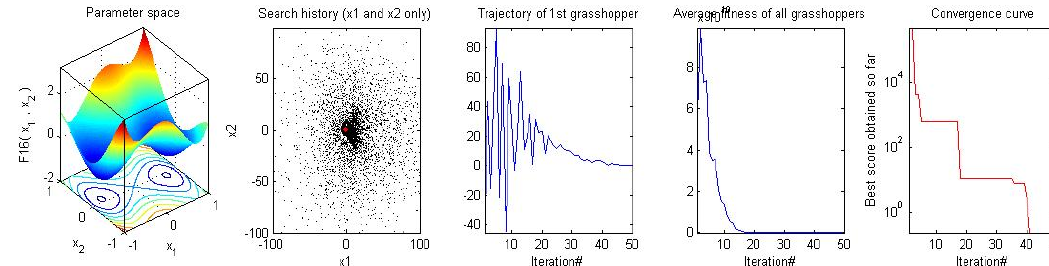
Figure 17. HAGOA behavior on multimodal function (F16)